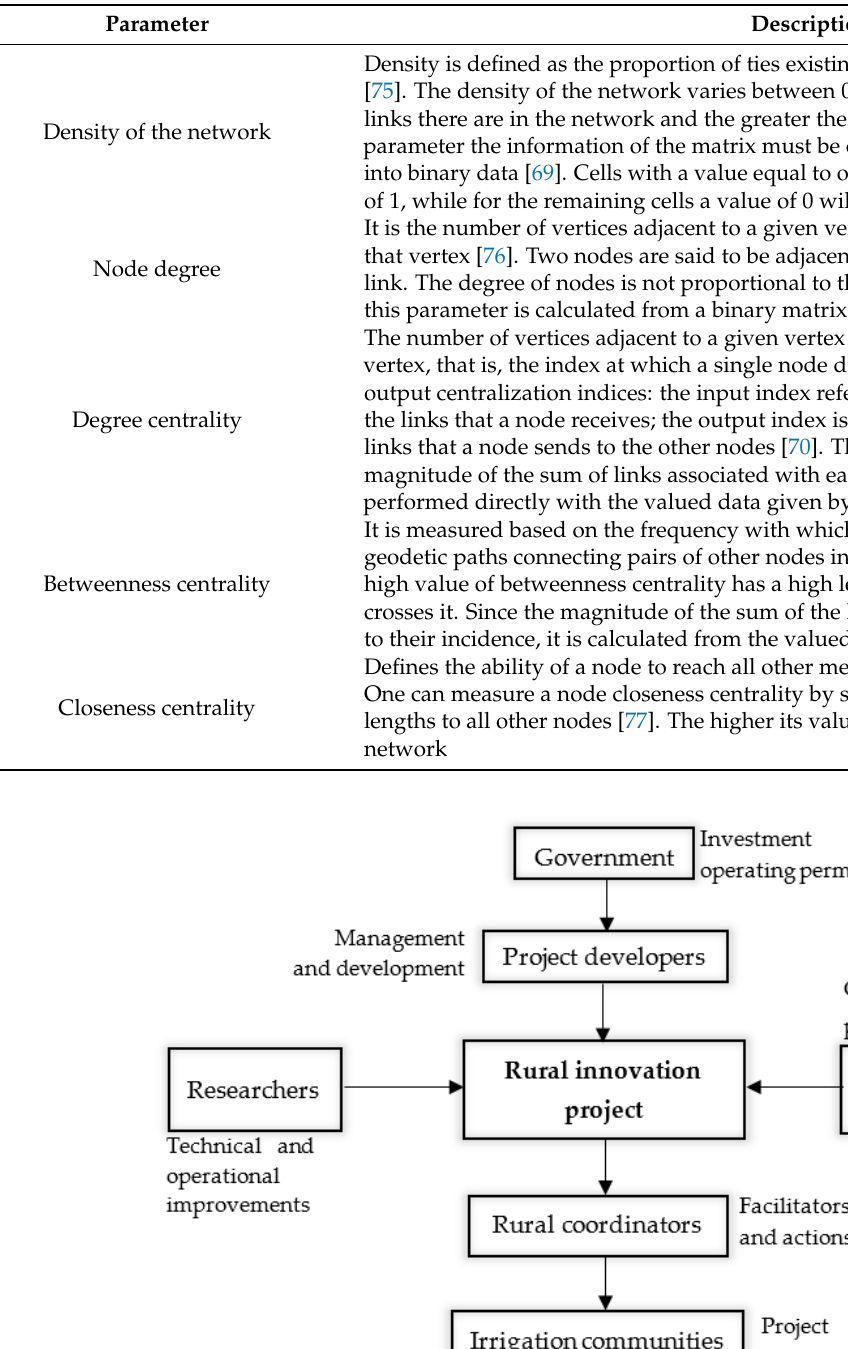
Figure 3. Location of the case study in Spain. Source: Author elaborator. As a rural innovation project, this initiative faces a series of challenges, among which conflicts arise between the various actors involved when developing and managing the project. On the one hand, there are irrigation communities and rural coordinators who, from a rural context, are characterized by their cultural roots and traditional work prac- tices. On the other hand, there are actors established in urban areas, which are mainly made up of business teams and state companies, which seek to develop new business opportunities in rural areas to implement innovative technology and systems. To these two predominant actors, a group of actors involved from the spheres of state regulation, research, suppliers and construction contractors, which can be decisive when managing